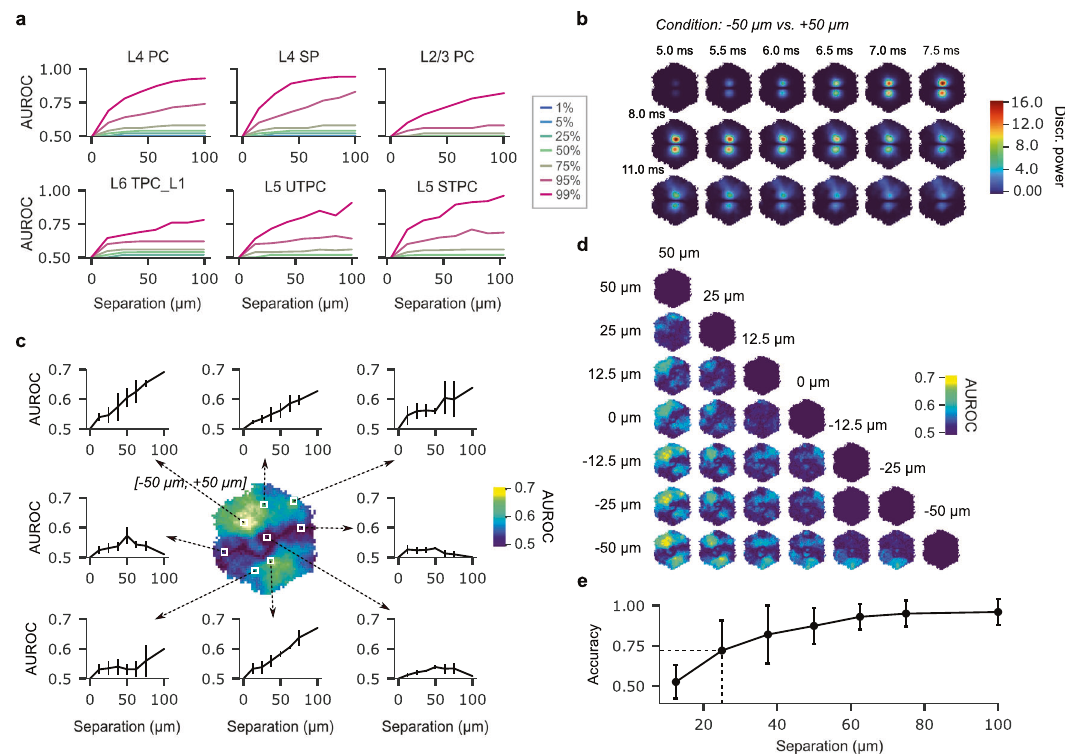
Fig. 5 VSDI pixel-wise two-point discrimination of VPM input locations. Various measures of circuit activity were compared for their ability to discriminate between VPM input stimulus locations. a Spike trains of individual neurons were used to compute AUROC scores (representing capacity to differentiate between stimulus locations) as a function of stimulus separation. Colors in legend indicate percentile of discrimination capacity within each subpopulation. b Discrimination power at discrete time points for stimuli positioned at − 50 µ m and + 50 µ m along a vertical axis bisecting the VSD image plane. Pixels are the negative log p value of the null hypothesis that the VSDI data associated with each stimulus location come from the same distribution. c Center: summary map of discrimination performance (AUROC score) considering the entire time course of each VSDI pixel for stimuli at − 50 µ m and + 50 µ m. Surrounding plots: AUROC score as a function of increasing stimulus separation at several pixel locations indicated by white boxes (mean values, n = (7, 8, 10, 8, 6, 4, 4, 2) independent scores per separation (0, 12.5, 25, 37,5, 50, 62.5, 75, 100 µ m, respectively) re fl ecting the number of possible stimulus location pairings at that separation). Error bars indicate standard deviation for each separation. d Matrix of AUROC score maps for each combination of stimulus locations. e XGBoost-based classi fi cation accuracy as a function of stimulus separation considering all pixels at all time points (mean values, n = (20, 25, 20, 15, 10, 10, 5) independent scores per separation (12.5, 25, 37,5, 50, 62.5, 75, 100 µ m, respectively), re fl ecting the number of possible (unique) stimulus location pairings at that separation evaluated with fi vefold cross-validation). Dashed lines indicate threshold (25 µ m, ~75% accuracy) below which classi fi cation performance drops considerably. Whiskers indicate standard